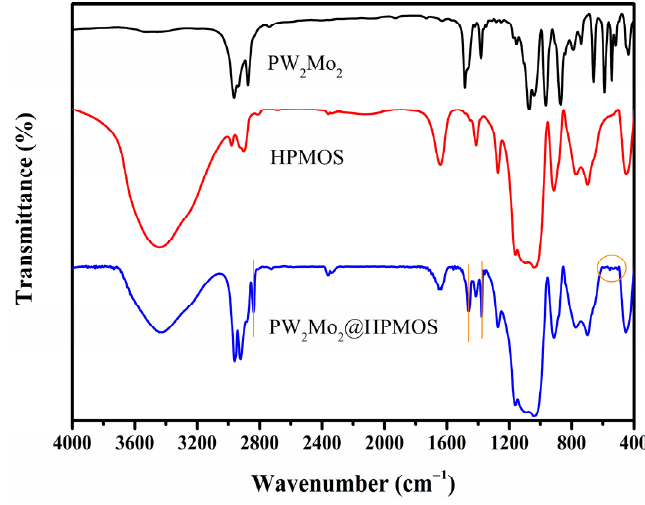
Figure 1. FT-IR spectra of PW 2 Mo 2 , HPMOS, and PW 2 Mo 2 @HPMOS.